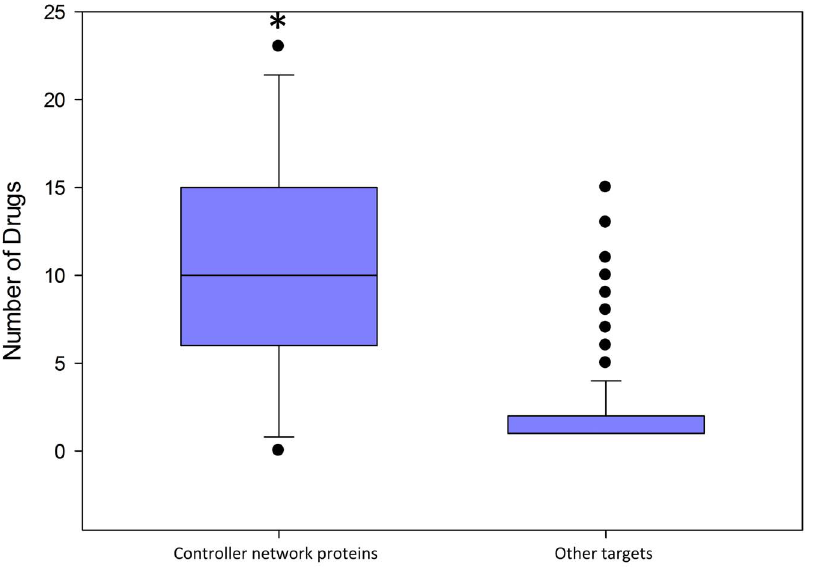
Figure 5. Effect of anti-psoriatic drugs on controller network. Higher number of effective anti-psoriatic drugs act on controller nodes than on other proteins. Totally the targets of 32 effective anti-psoriatic drugs were analyzed (median 10 vs. 1) *p , 0.001